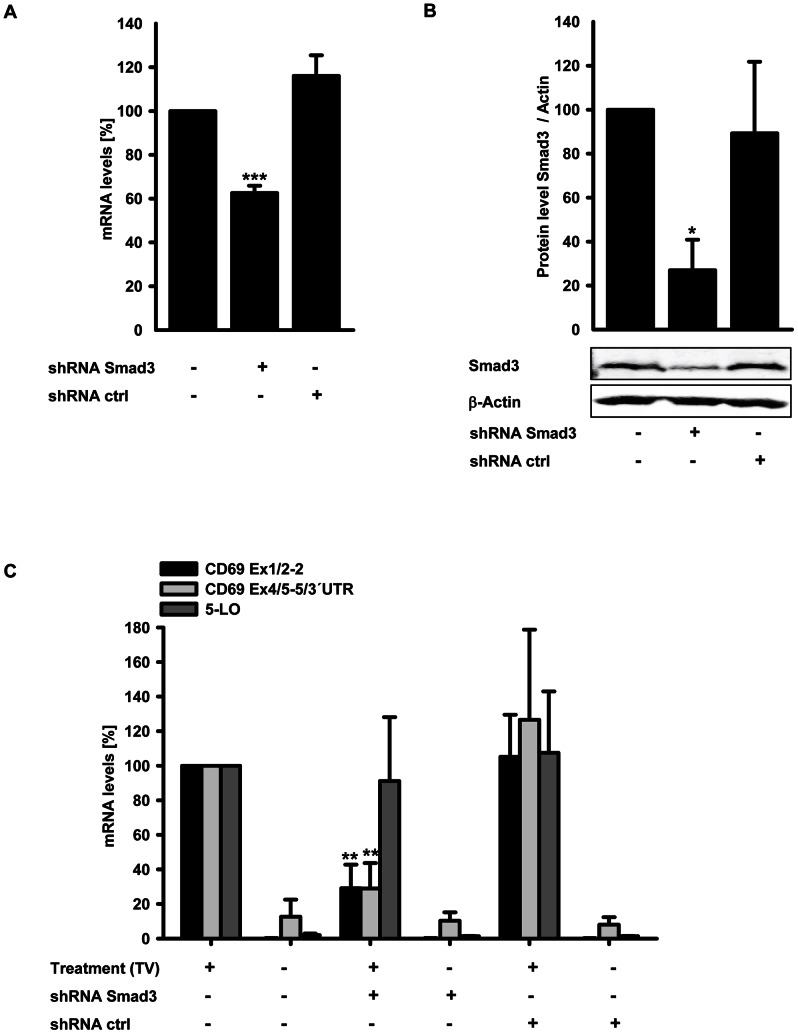
Effects of Smad3 gene silencing on CD69 and 5-LO gene regulation by TGF-β/1α,25(OH)2D3.(A) Smad3 mRNA copy numbers of untransduced THP-1, THP-1 transduced with shRNA against Smad 3 and THP-1 transduced with non target shRNA were determined by qPCR. Smad 3 mRNA levels are displayed relative to untransduced THP-1 cells. (B) Western Blot analysis of Smad3 protein in untransduced THP-1, THP-1 transduced with shRNA against Smad3 and THP-1 transduced with non target shRNA. Protein level is displayed relative to untransduced THP-1. (C) qPCR analysis of CD69 and 5-LO mRNA levels in untransduced THP-1, THP-1 transduced with shRNA against Smad3 and THP-1 transduced with non target shRNA with and without treatment with 1 ng/ml TGF-β and 50 nM 1α,25(OH)2D3 (TV) for 24 h, respectively. Results are presented relative to treated untransduced THP-1. For statistical analysis of (A), (B) and (C) one sample t test was used (*P<0.05; **P<0.01; ***P<0.001).